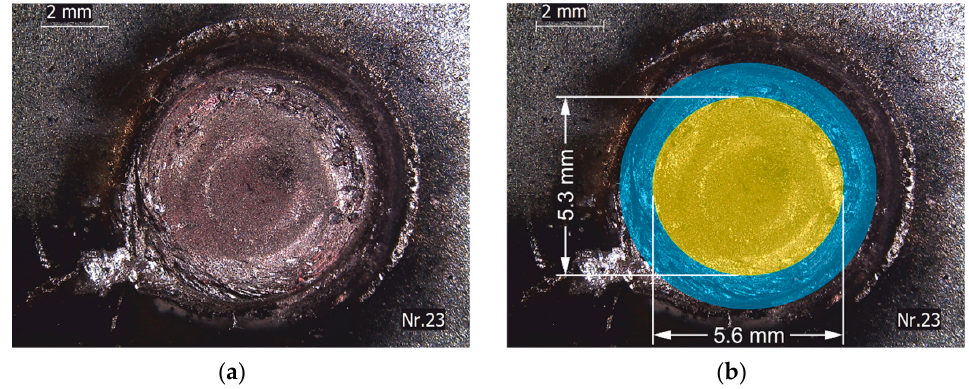
Figure 2. Exemplary specimen after torsion testing: ( a ) weld nugget after torsion testing; ( b ) adhesive zone is represented by the blue ring, and the yellow circle marks the weld nugget.